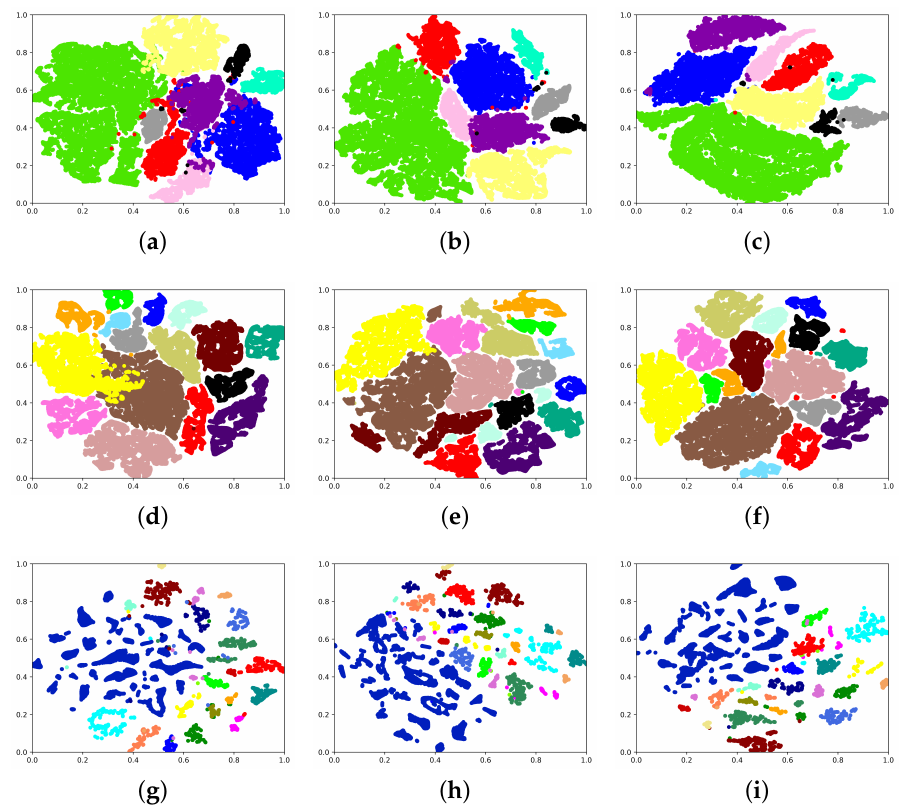
Figure 14. Feature separability for different methods in the three data sets. ( a ) DLSN, ( b ) ALSN with AUAL, and ( c ) ALSN with AUAL and ICUAL for PaviaU. ( d ) DLSN, ( e ) ALSN with AUAL, and ( f ) ALSN with AUAL and ICUAL for Salinas. ( g ) DLSN, ( h )ALSN with AUAL, and ( i ) ALSN with AUAL and ICUAL for